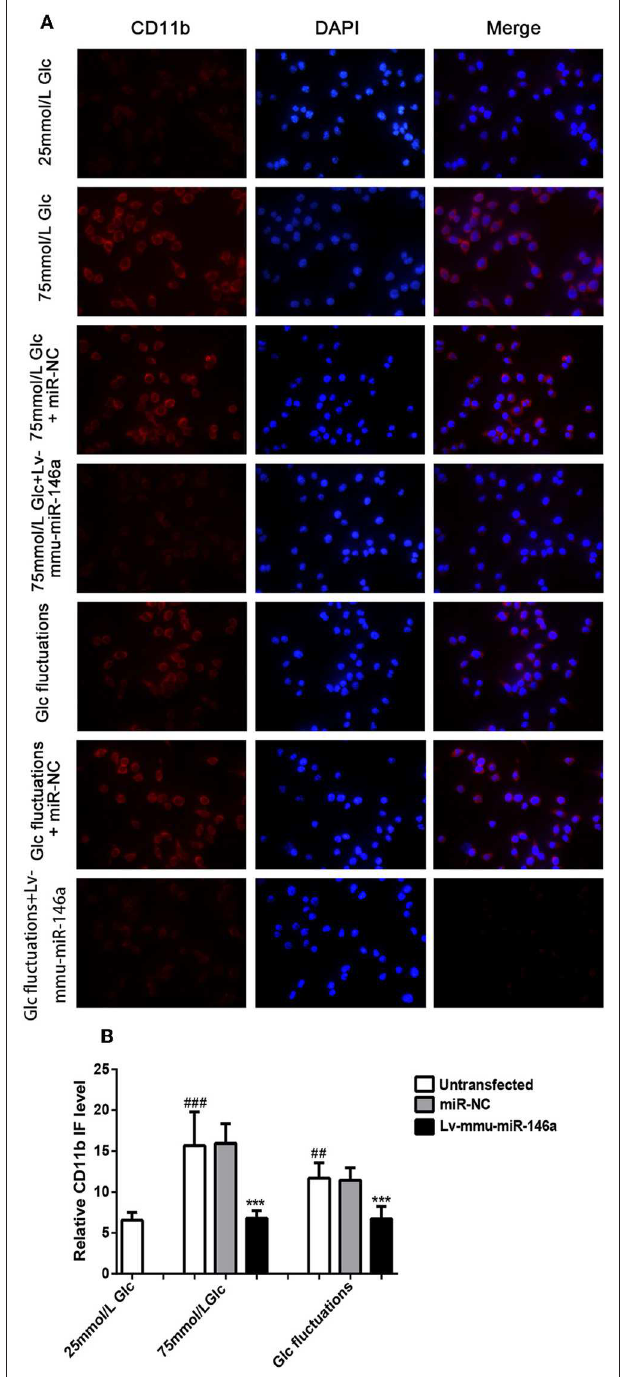
FIGURE 3 | Immunofluorescence for CD11b in BV-2 cells overexpressing miR-146a induced by high glucose and glucose fluctuations for 48h. (A) Immunofluorescence was used to measure the expression of CD11b protein in BV-2 cells overexpressing miR-146a induced by high glucose and glucose fluctuation. (B) Comparison of CD11b protein immunofluorescence intensity. ### p < 0.001, 75 mmol/L Glc vs. control; ## p < 0.01, Glc fluctuation group vs. control. *** p < 0.001, 75 mmol/L Glc + Lv-mmu-miR-146a group vs. 75 mmol/L Glc group, Glc fluctuation + Lv-mmu-miR-146a group vs. Glc fluctuation